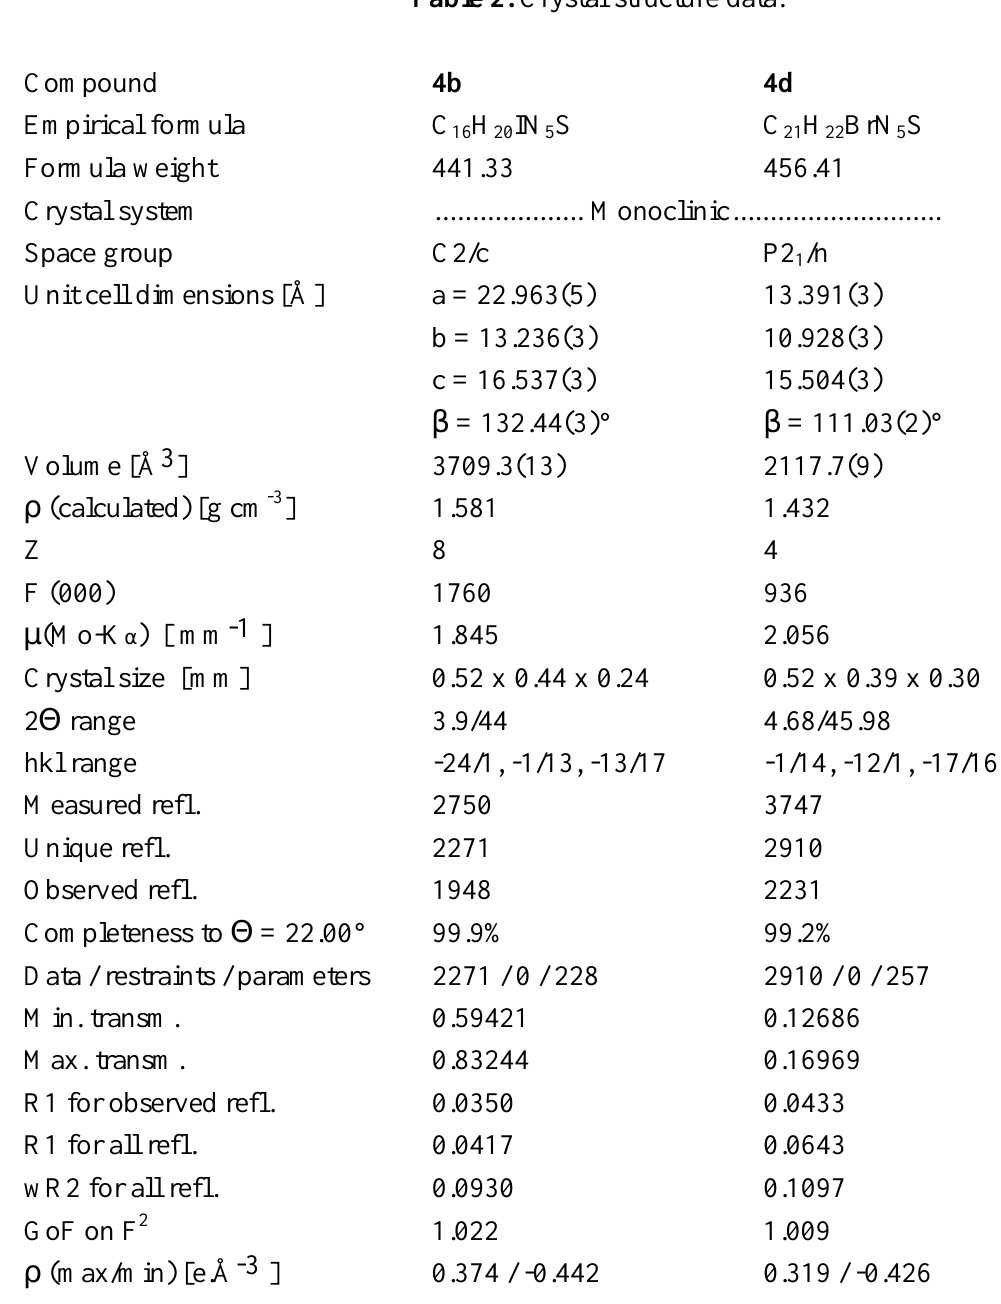
Table 2. Crystal structure data.